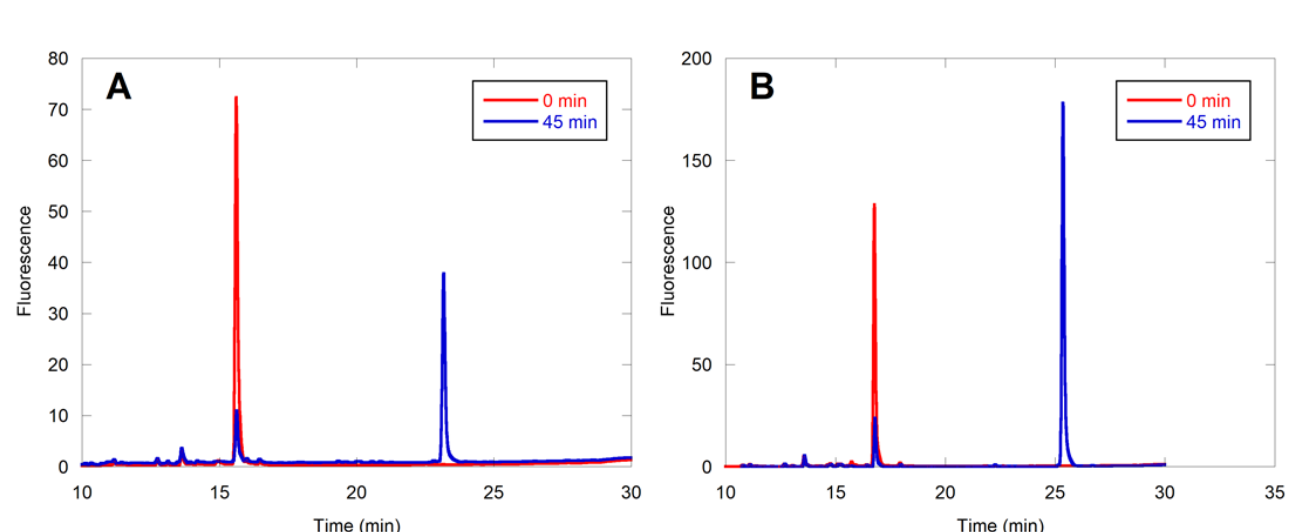
Figure 5. HPLC assays displaying that the best peptide from the bioinformatic screen (CSLMQ) was able to show near- identical conversion to a native tetrapeptide sequence CVLS (85% vs. 84%, respectively). The quantification was performed as in Figure 4. Reactions contained 2.4 µM peptide, 10 µM FPP, and 25 nM enzyme. ( A ) DsGRAGCSLMQ with 25 nM rFTase; ( B ) DsGCVLS with 25 nM yFTase.